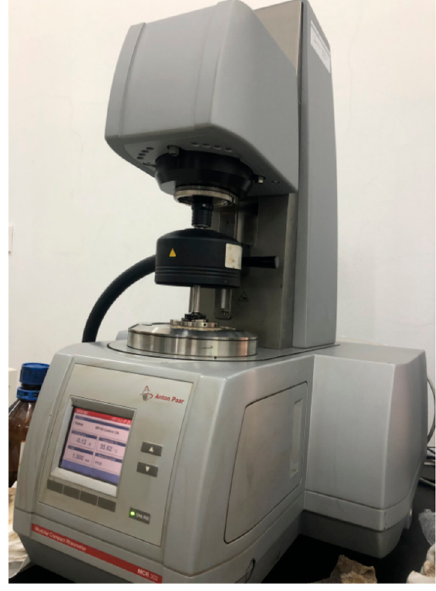
Figure 5. Dynamic shear rheometer.